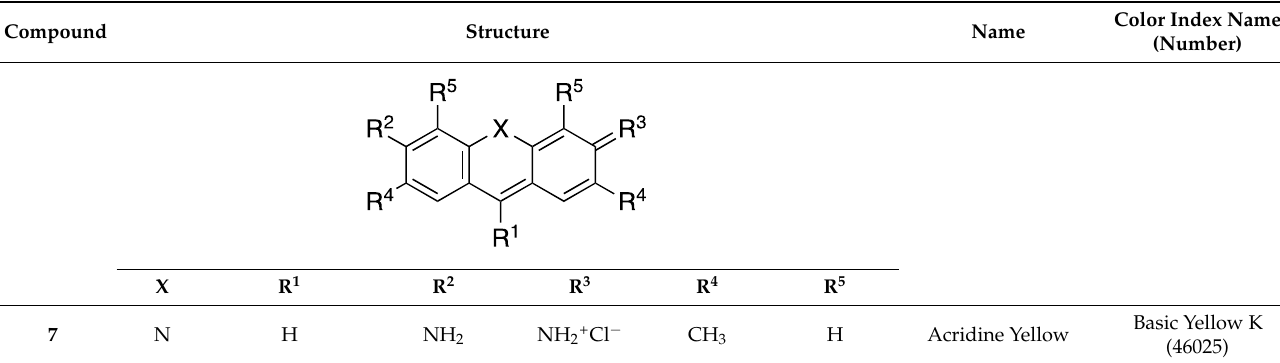
Table 2. Arylmethane heterocyclic (acridine and xanthene) dyes.